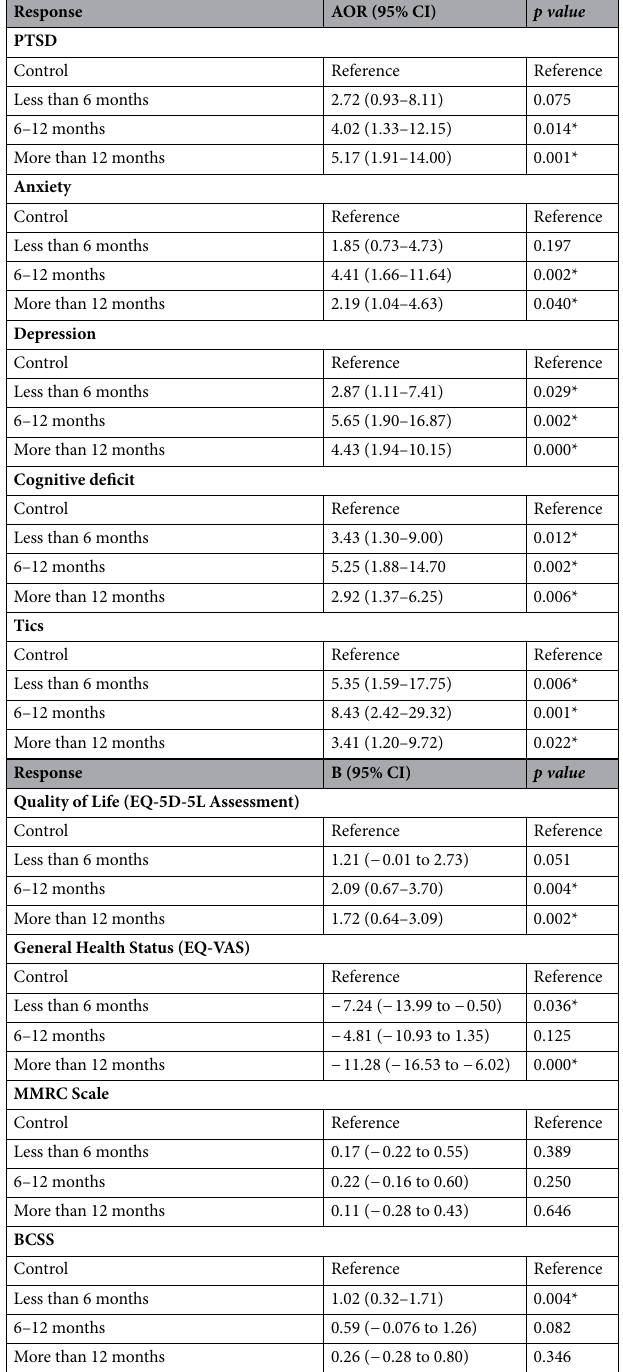
Table 3. Multivariate logistic regression of the COVID-19 infection durations and PACS. This table shows the comparison between the COVID-19 infection durations of COVID-19 patients and the controls to assess the prevalence of PACS symptoms among COVID-19 survivors. *P value < 0.05. PTSD Posttraumatic stress disorder, VAS Visual Analogue Scale, EQ-5D-5L EuroQol 5-dimension 5-level assessment, MMRC Modified Medical Research Council scale, BCSS Breathlessness, Cough, and Sputum